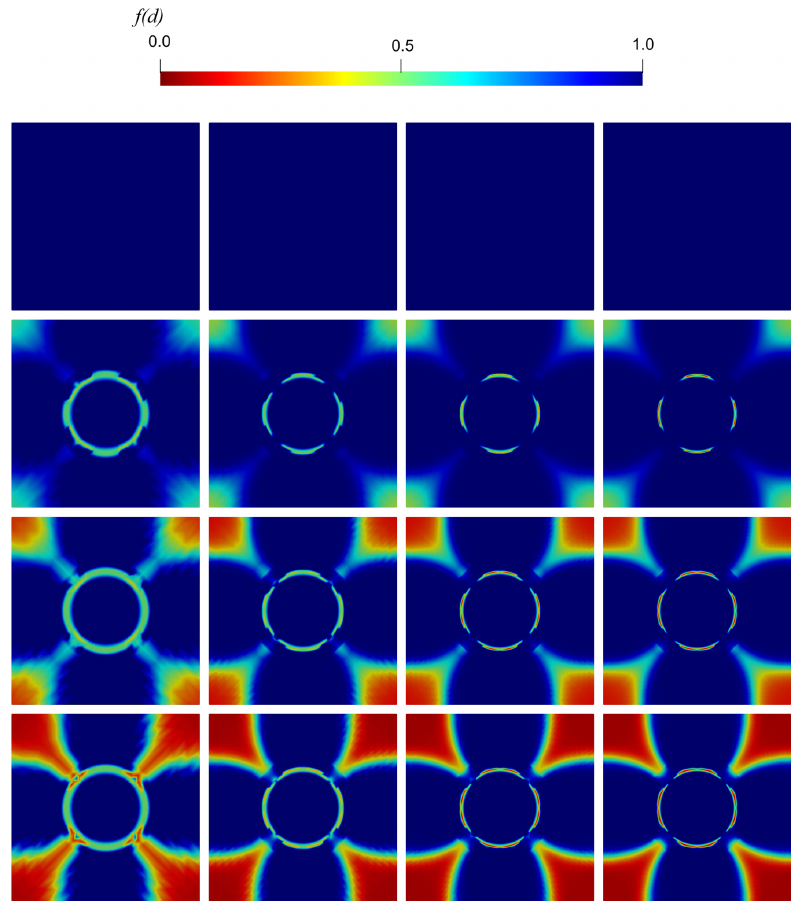
Figure 9: Shear: distribution of damage function 𝑓(𝑑) for 1024, 3136, 6400 and 10,816 elements (from left to right) for steps 150, 255, 270, and 290